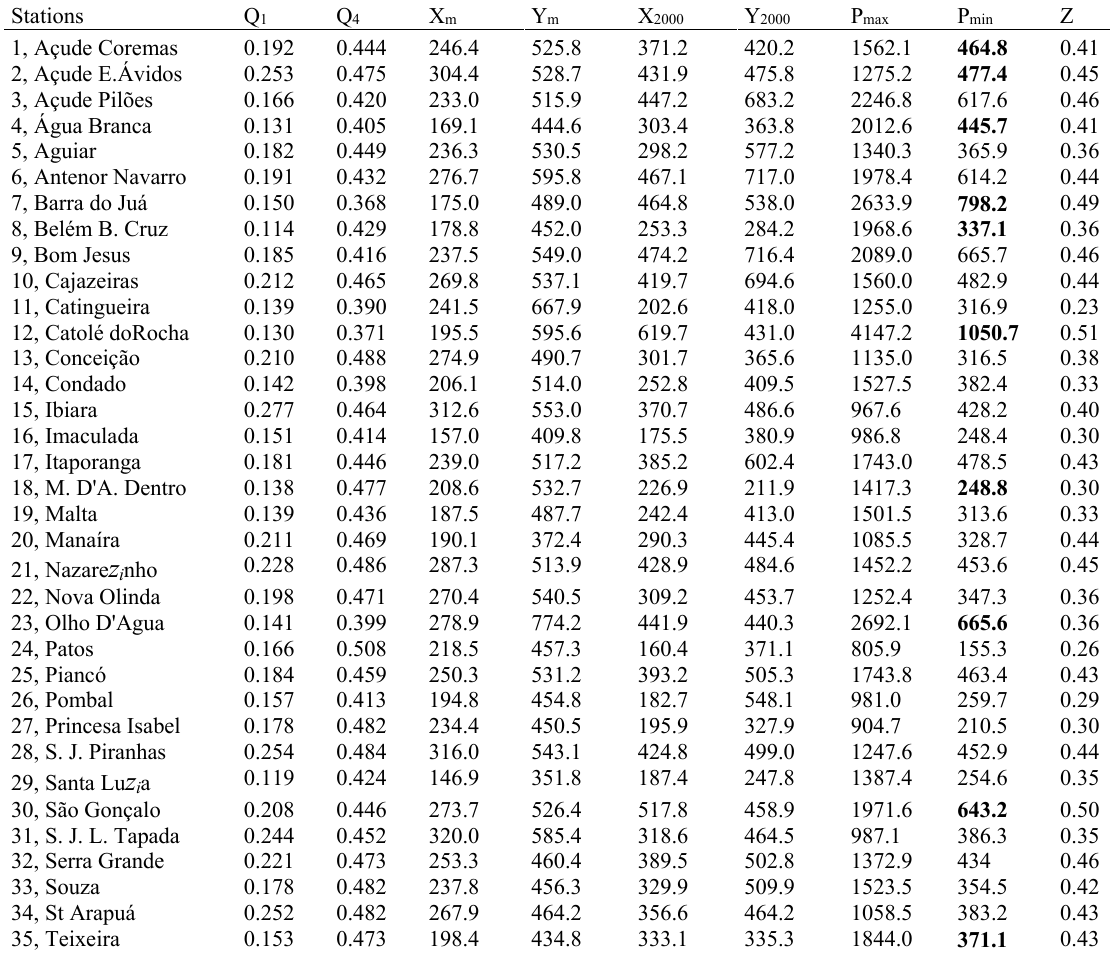
Table 2 Raingauge stations of Sertões with their correspondents data for the RS EC1: second ( Q 2 ) and eighth ( Q 8 ) deciles of z i , mean values of the first (X m ) and second (Y m ) period of EC1; forecasted maximun (P max ) and minimum (P min ) rainfall values for 2000 year; and the proportion variable for 2000 year – z i .